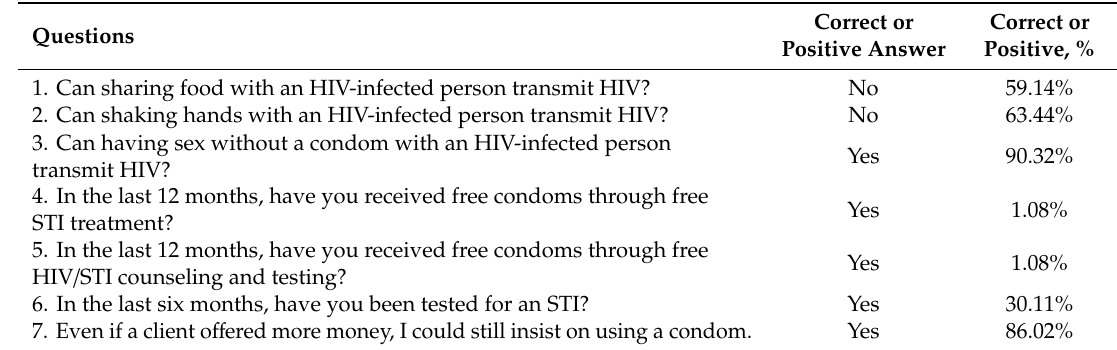
Table 1. Knowledge, attitude, and practice toward HIV / AIDS transmission and control ( n = 93). Note that Questions 1 to 3 relate to knowledge; 4 and 5 to attitude; and 6 and 7 to